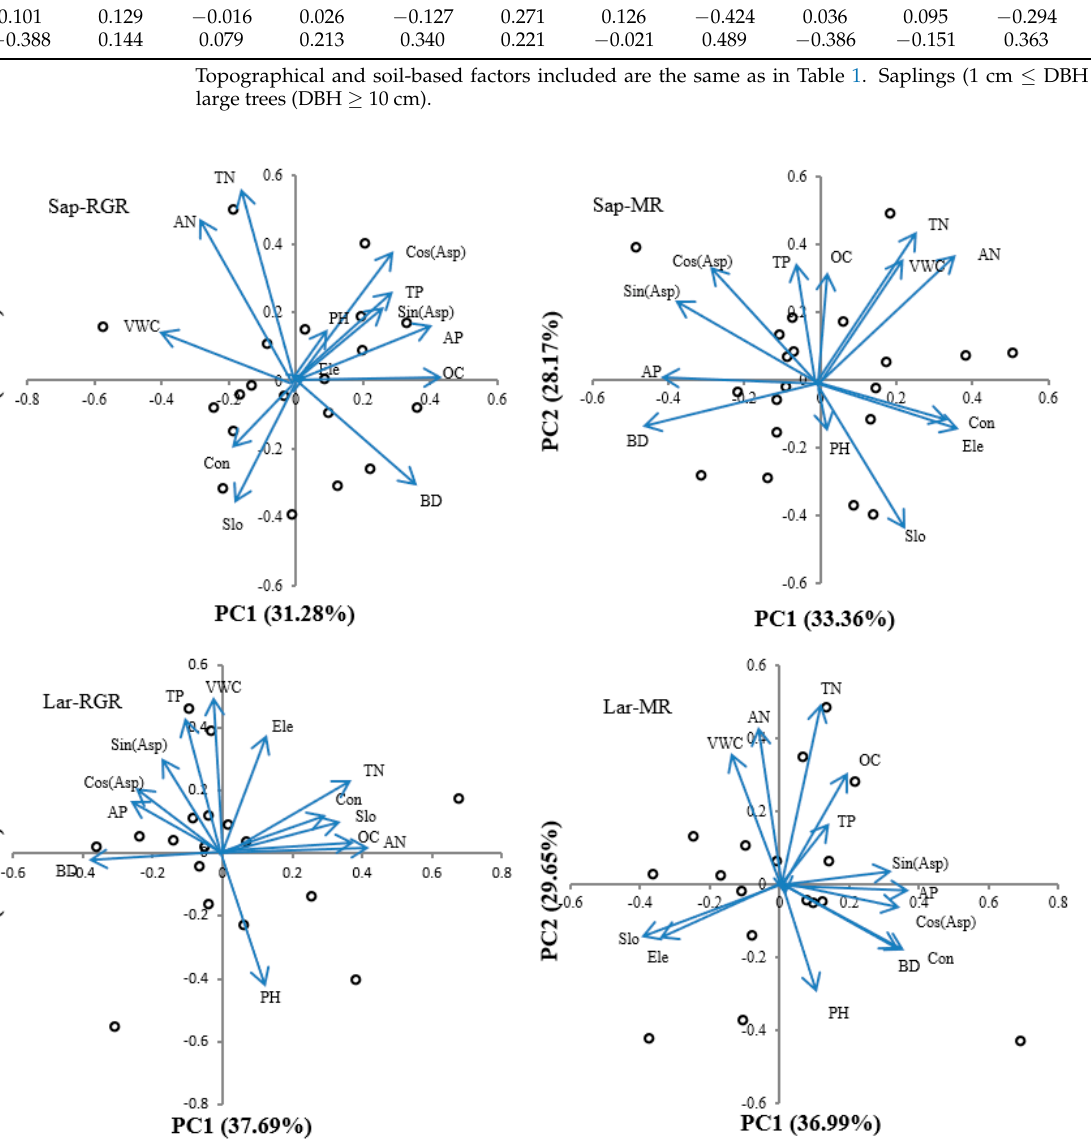
The scores of principal component analysis axis 3 (PC3) were negatively correlated with the RGR and MR at the large tree life stage ( p < 0.05). The scores of the first two axes of the principal component analysis (PC1 and PC2) were not correlated with the RGR or the MR of large trees. The scores of all principal component axes were not correlated with the RGR or the MR of saplings (Figure 3). RGR was related to declining AP and increas- ing VWC at the large tree life stage. MR was related to increasing Slo and declining VWC at the large tree life stage (Table 4 and Figure 3).